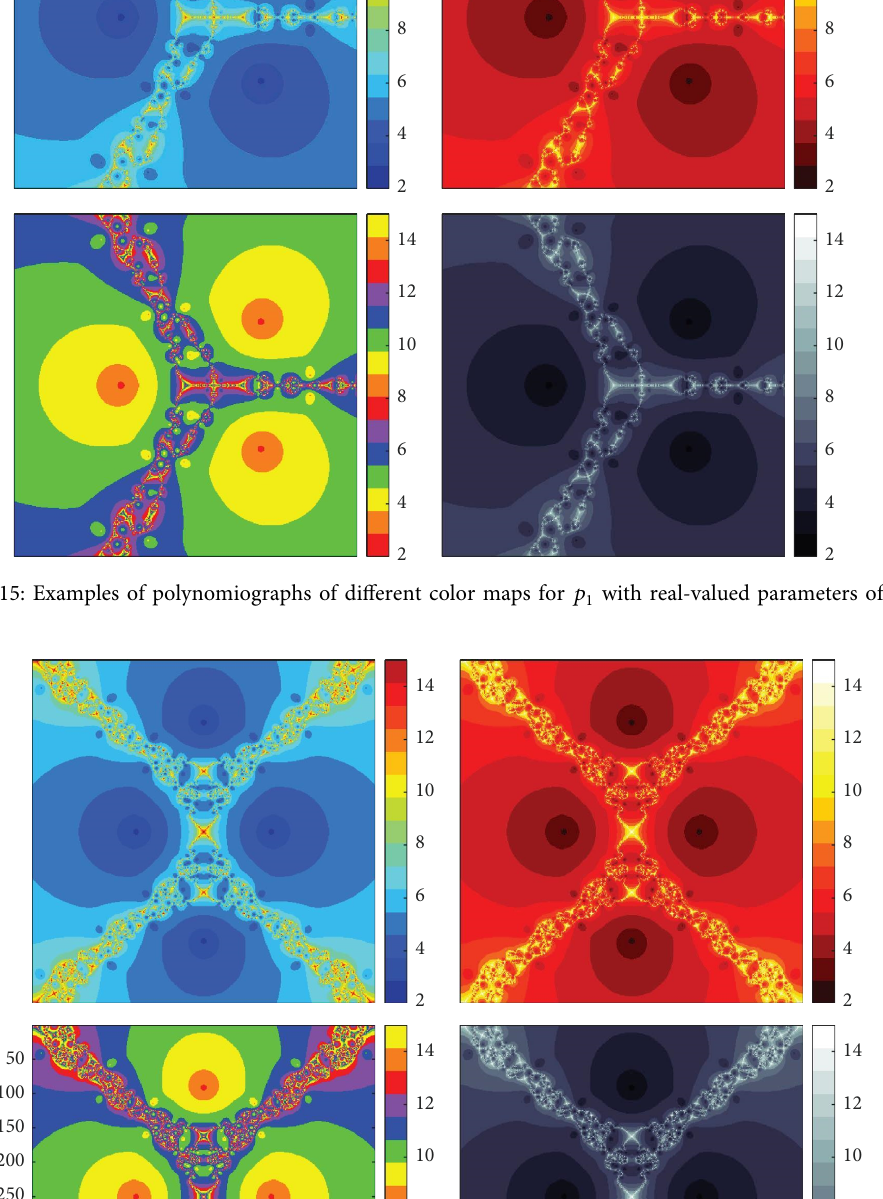
with real-valued parameters of 2